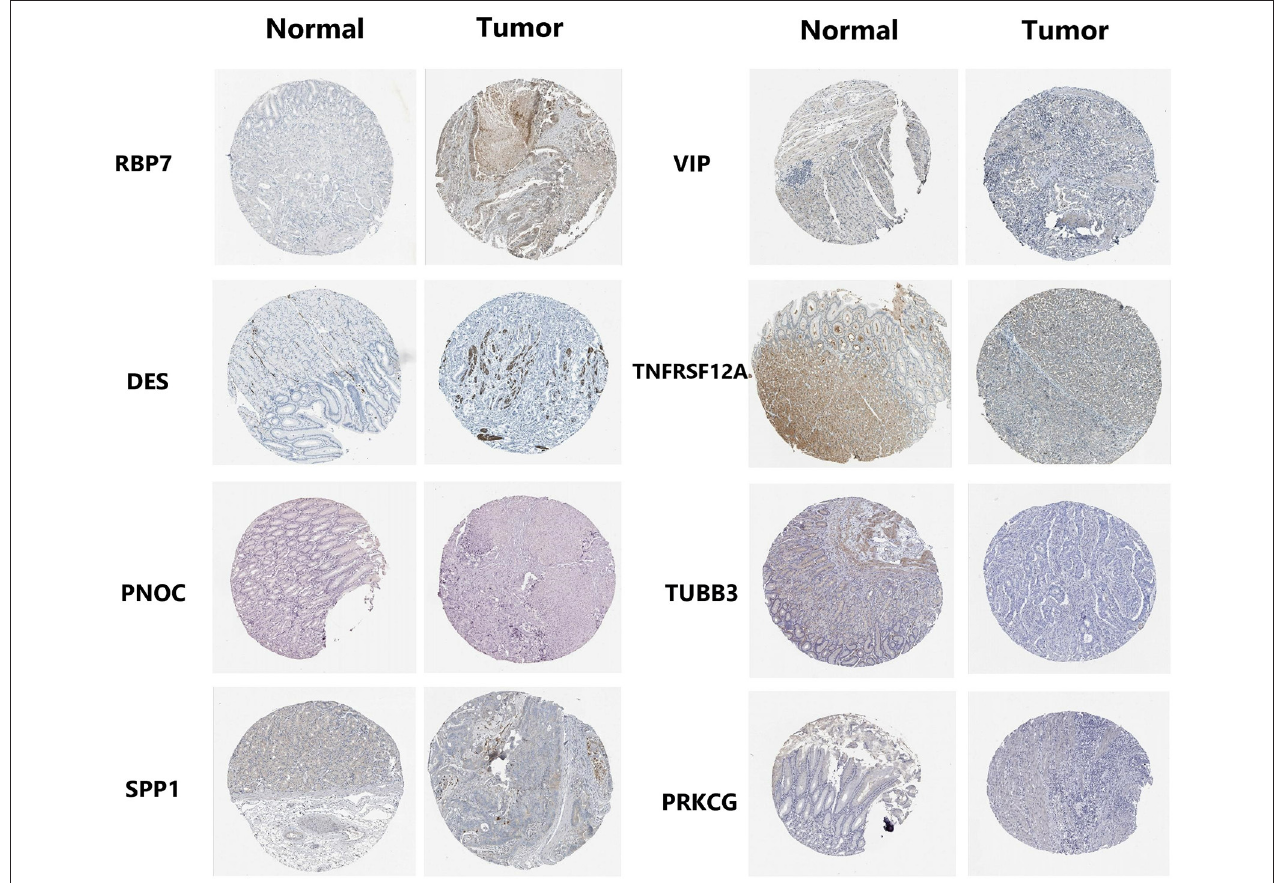
FIGURE 10 | Expression profiles of 8 genes in normal stomach tissues and gastric adenocarcinoma tissues. Immunohistochemical results were obtained from HPA